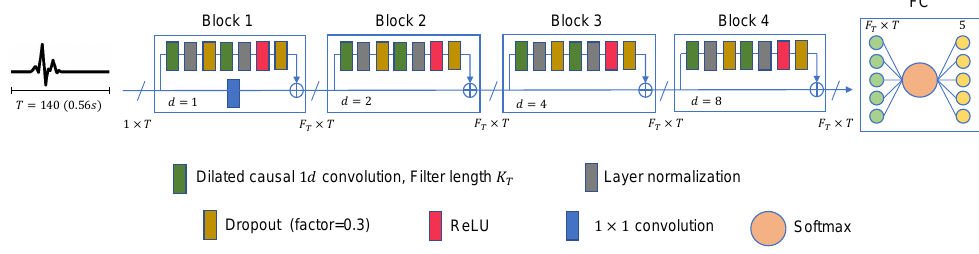
Figure 4. TCN architecture for ECG heartbeat classification. The input signal is made of 140 points (0.56 s). Number of filters is F T . Filter length is K T . Dilation factors of blocks are 1, 2, 4, and 8,